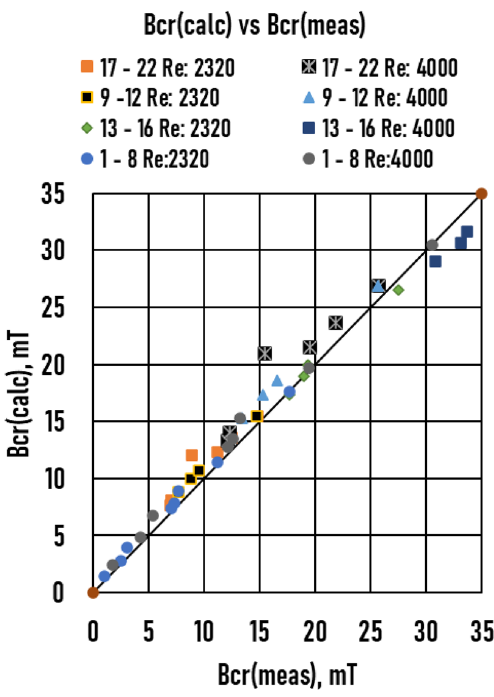
Figure 12. Comparison of the calculated (Calc. Bcr) and measured (Meas. Bcr) critical magnetic induction.